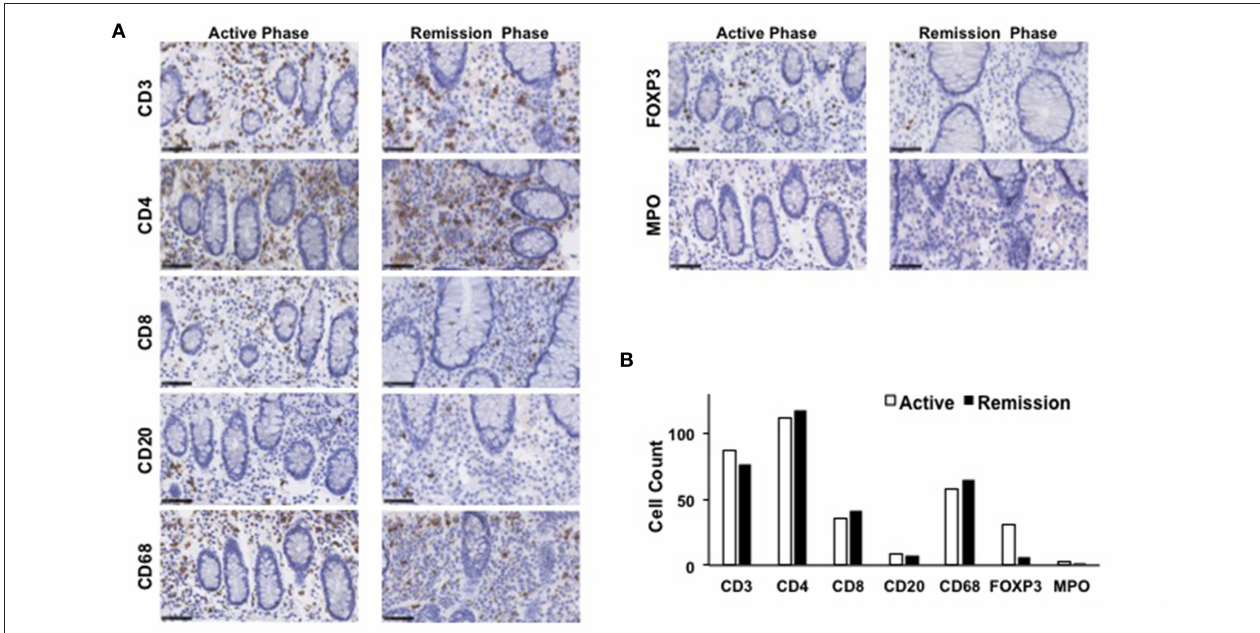
FIGURE 3 | Immunohistochemical analyses of the transverse colon biopsy samples obtained from a patient with collagenous colitis during the active and remission phases. (A) Colonic biopsy specimens were subjected to immunohistochemical analyses to visualize CD3 + T cells, CD4 + T cells, CD8 + T cells, CD20 + B cells,